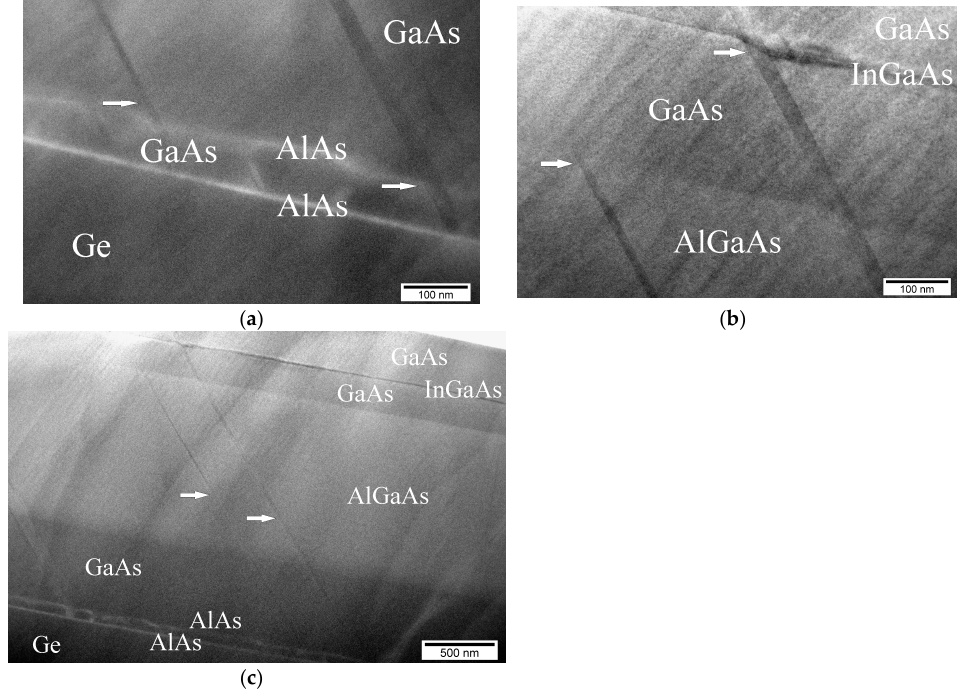
Figure 9. TEM images of the cross section of the laser heterostructure H: ( a ) Heterointerface with AlAs/GaAs/AlAs layers, ( b ) active region with InGaAs/GaAs QWs, ( c ) cross section of the entire heterostructure. The white arrows indicate